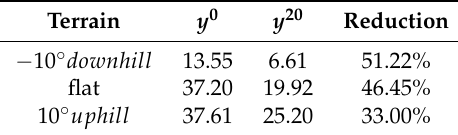
Figure 9. Experimental results of assistance strategy tracking for soft exoskeleton, where ( a ), ( b ) and ( c ) represent the results of downhill, flat, and uphill respectively, y D is the desired assistance force, y 0 is shows the tracking performance without POILC (no learning, iteration 0), and y 20 shows the performance improved after applying POILC for 20 iterations . Table 2. The RMSE in different slopes with POILC and without POILC, where y 0 and y 20 are the tracking results with and without POILC,